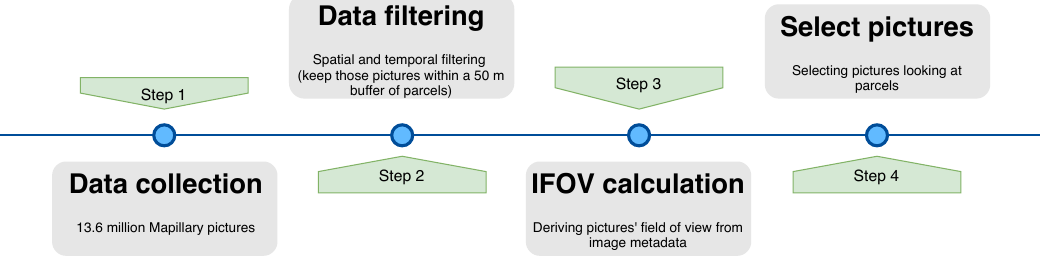
Figure 2. Methodological flowchart of the availability and usability assessment for Mapillary images in the Netherlands. Table 1. Aggregated crop classes and their respective growing